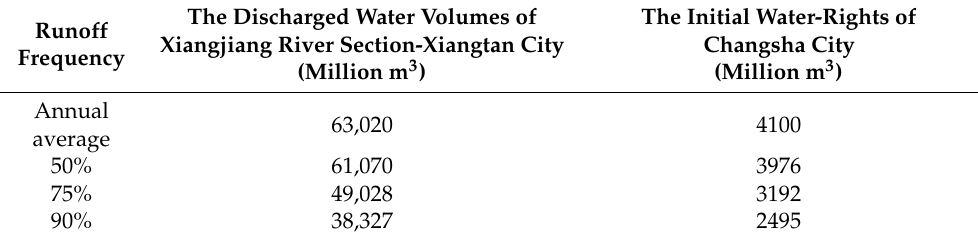
Table 4. The initial water rights of Changsha city under different runoff frequencies in 2030.